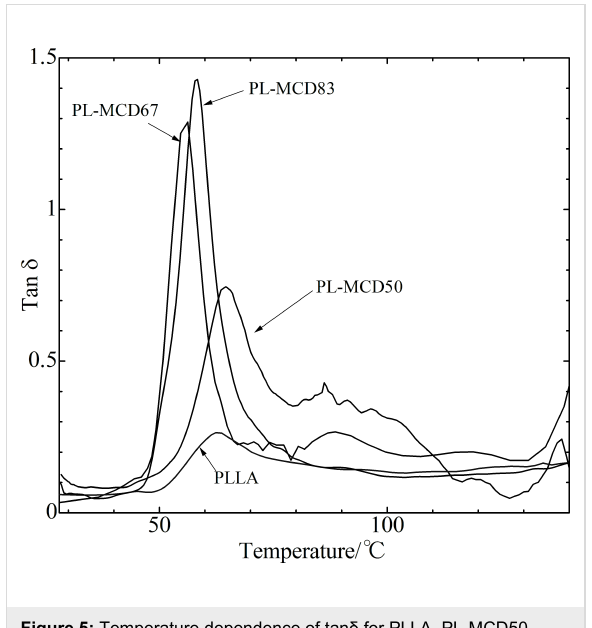
Figure 5: Temperature dependence of tan δ for PLLA, PL-MCD50, PL-MCD67 and PL-MCD83.